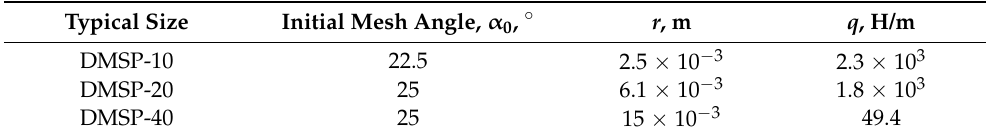
Table 3. Values of adjusting factors.